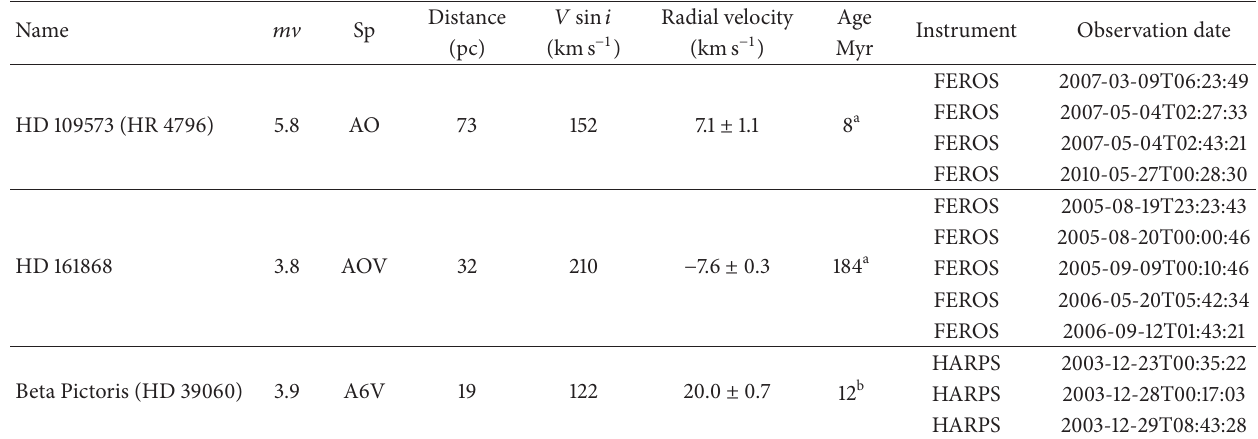
Table 2: ESO data archival